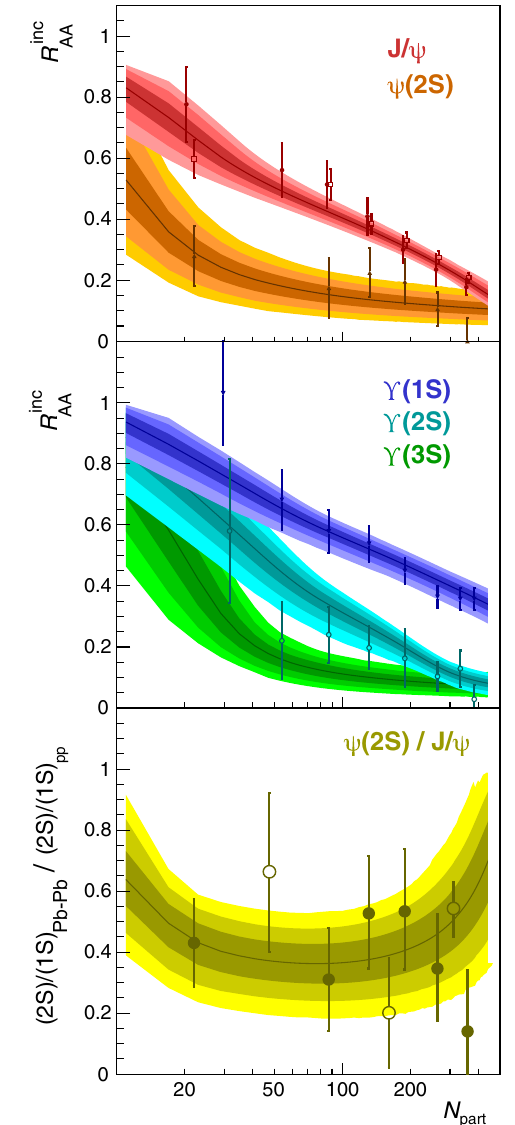
Fig. 5 R inc curves resulting from the global fit, with bands repre- AA senting the 68, 95 and 99.7% confidence level intervals, compared to the corresponding charmonium (top) and bottomonium (middle) mea- surements by CMS (closed markers) and ATLAS (open markers), as a function of N part . The corresponding ψ( 2S ) -to-J /ψ double ratios (not included as fit constraints) are shown in the bottom panel